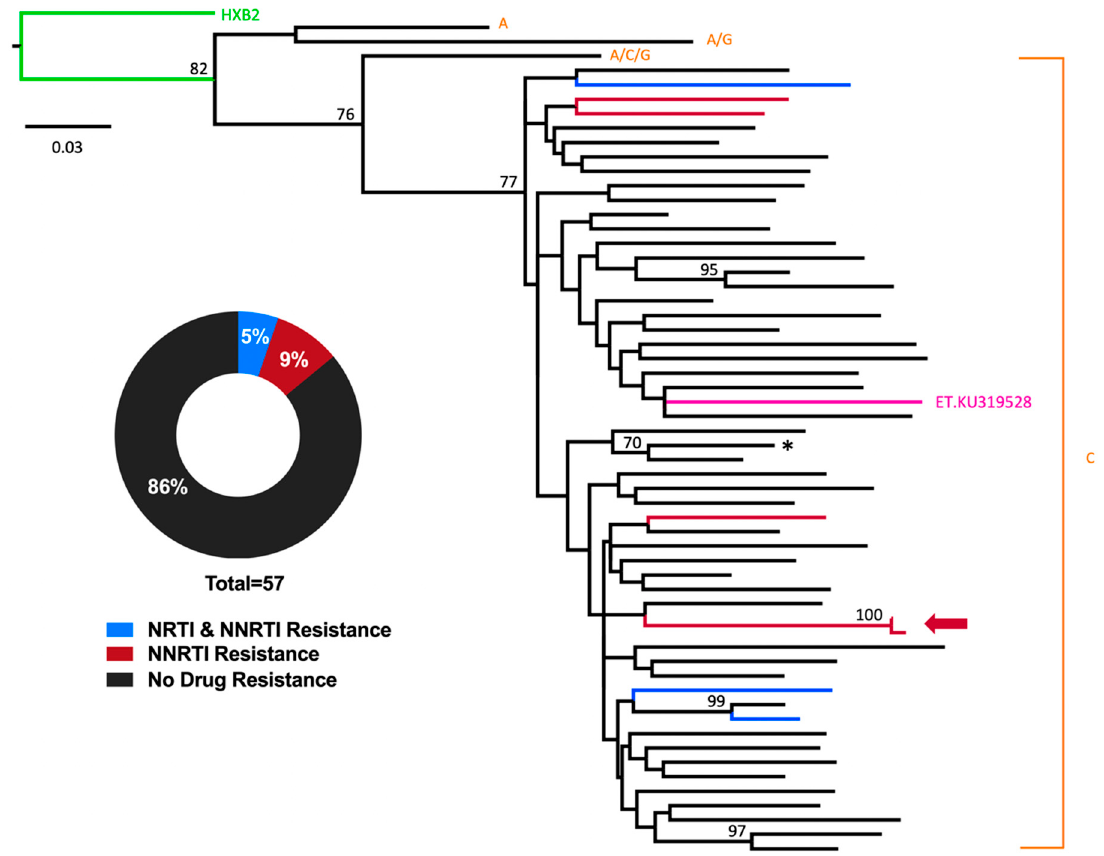
Figure 1. Prevalence of HIV-1 pretreatment HIV drug resistance (PDR) among combination antiretroviral therapies (cART)-naïve Ethiopian children. A maximum-likelihood phylogeny was inferred from the inclusive HIV consensus sequences of the 57 participants for whom genotyping was successful. Drug resistance codons were removed from the alignment prior to phylogenetic inference. Scale indicates expected substitutions per nucleotide site. Nodes with bootstrap values ≥ 70% are indicated on the tree. Colors indicate resistance genotype. HIV-1 subtypes are indicated at tree tips. Reference strains HXB2 (subtype B, green) and KU319528 (subtype C-Ethiopia, pink) are included. The arrow denotes a sibling pair harboring similar HIV sequences. The asterisk denotes a single participant harboring an E138A mutation in reverse transcriptase; this mutation is not on the list of WHO surveillance drug resistance mutations, and therefore this participant is classified in the “no drug resistance” category. However, this mutation confers low-level resistance to the non-nucleoside reverse transcriptase inhibitors (NNRTI) rilpivirine [36].